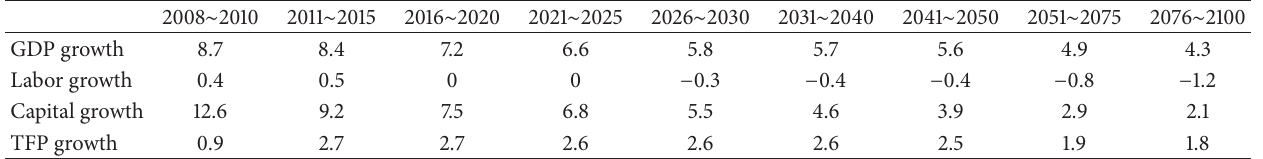
Table 2: Economic growth under the REG scenario in 2008–2100 (unit: